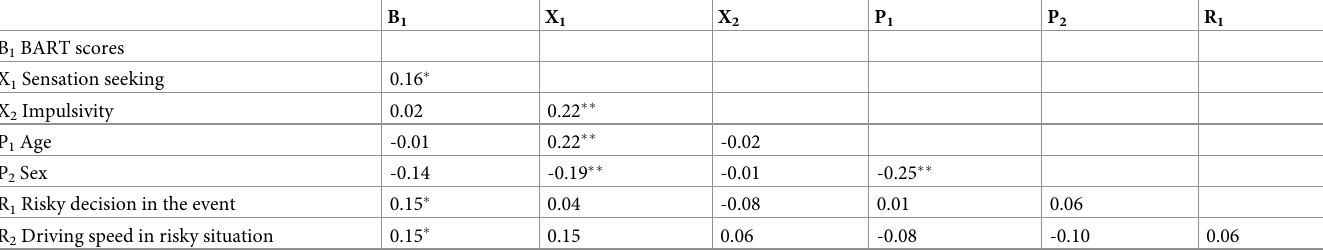
Table 2. Correlations between driving experience, personality traits, age, sex, BART scores, and risky decision-making.